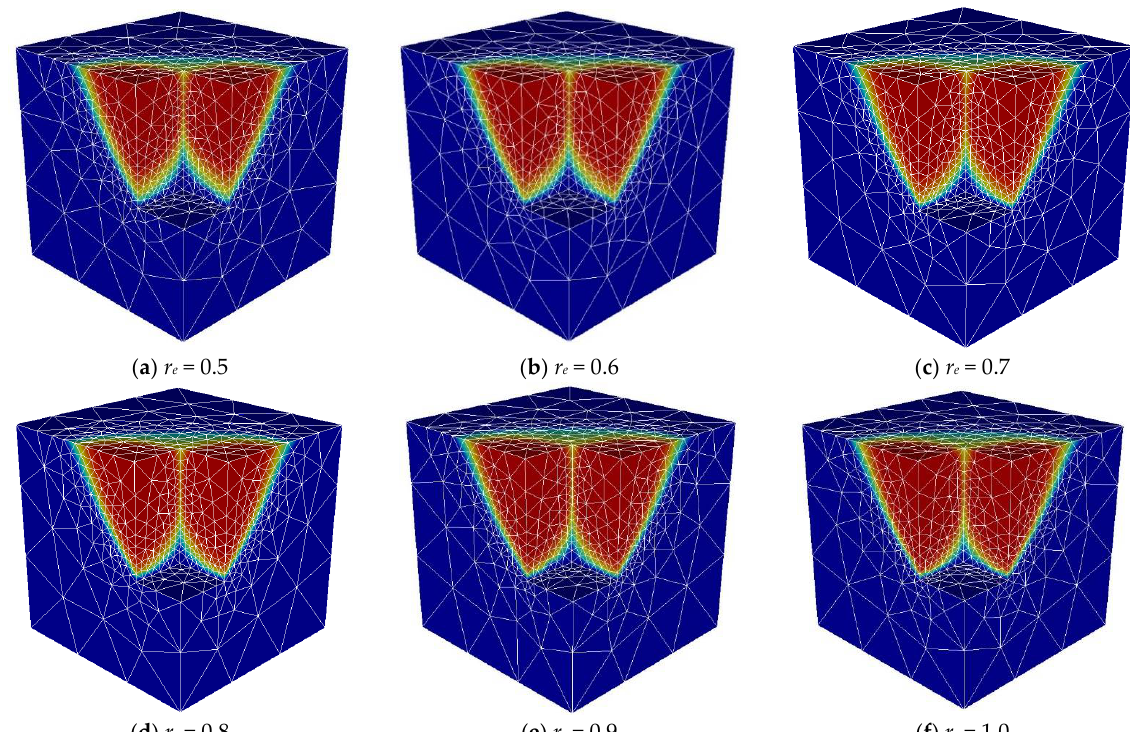
Figure 12. Potential failure mechanisms—effect of r e ( m = 4, H/B = 1, and B/L = 1).